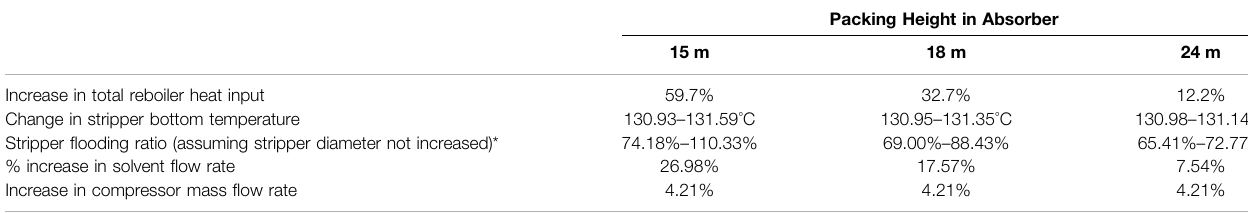
TABLE 7 | Changes in operating parameters for a 95% capture design that was operated at 99%